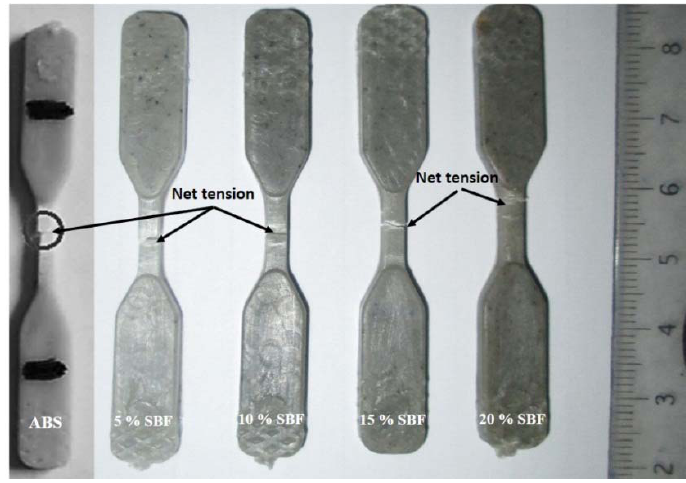
Figure 6. Failure modes in the tensile test specimens.